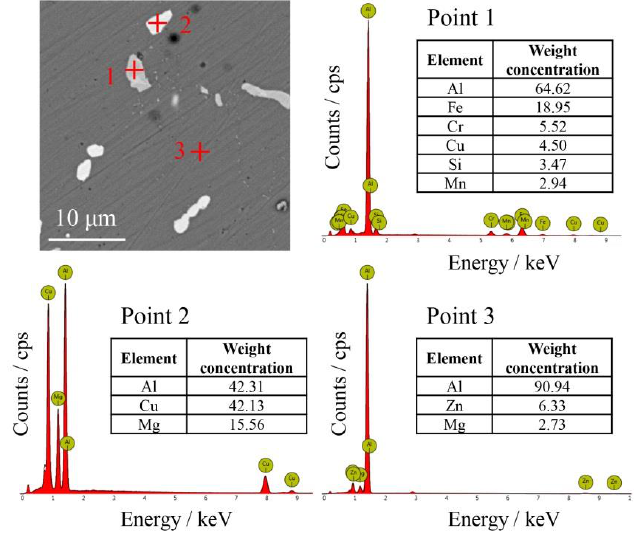
Figure 3. SEM and EDS analysis of the 7075 raw material.